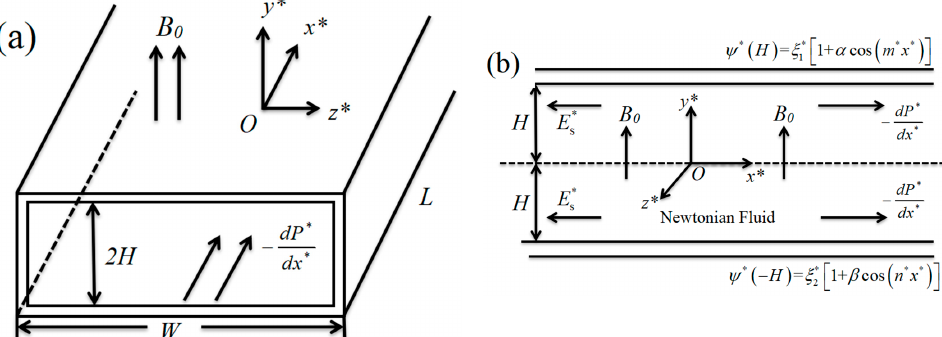
Figure 1. Schematic of the physical model. ( a ) 3D view of microchannel; ( b ) The cross section of the microchannel.